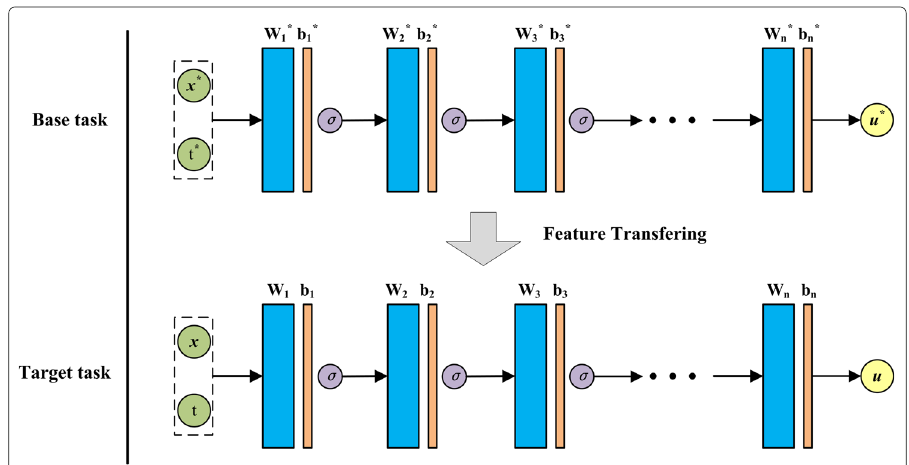
Fig. 1 Overview of the transfer learning approach. Instead of initializing the entire network randomly, the usual transfer approach is to train a base network on a large dataset and then copy (transfer) its first n layers to the first n layers of a target network. The remaining layers are randomly initialized and trained toward the target